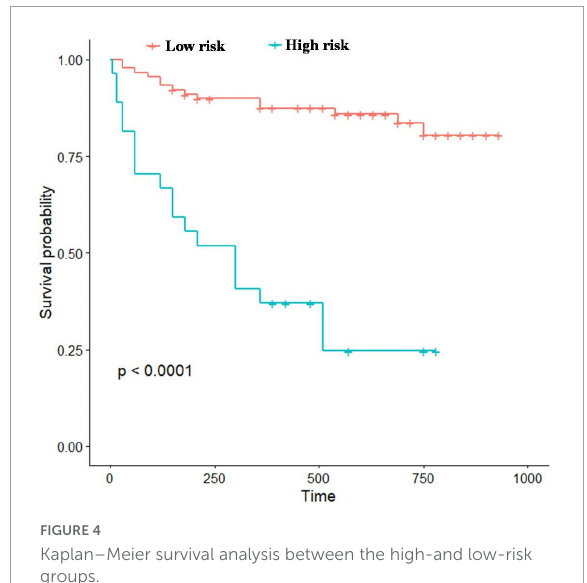
FIGURE4 Kaplan–Meier survival analysis between the high-and low-risk